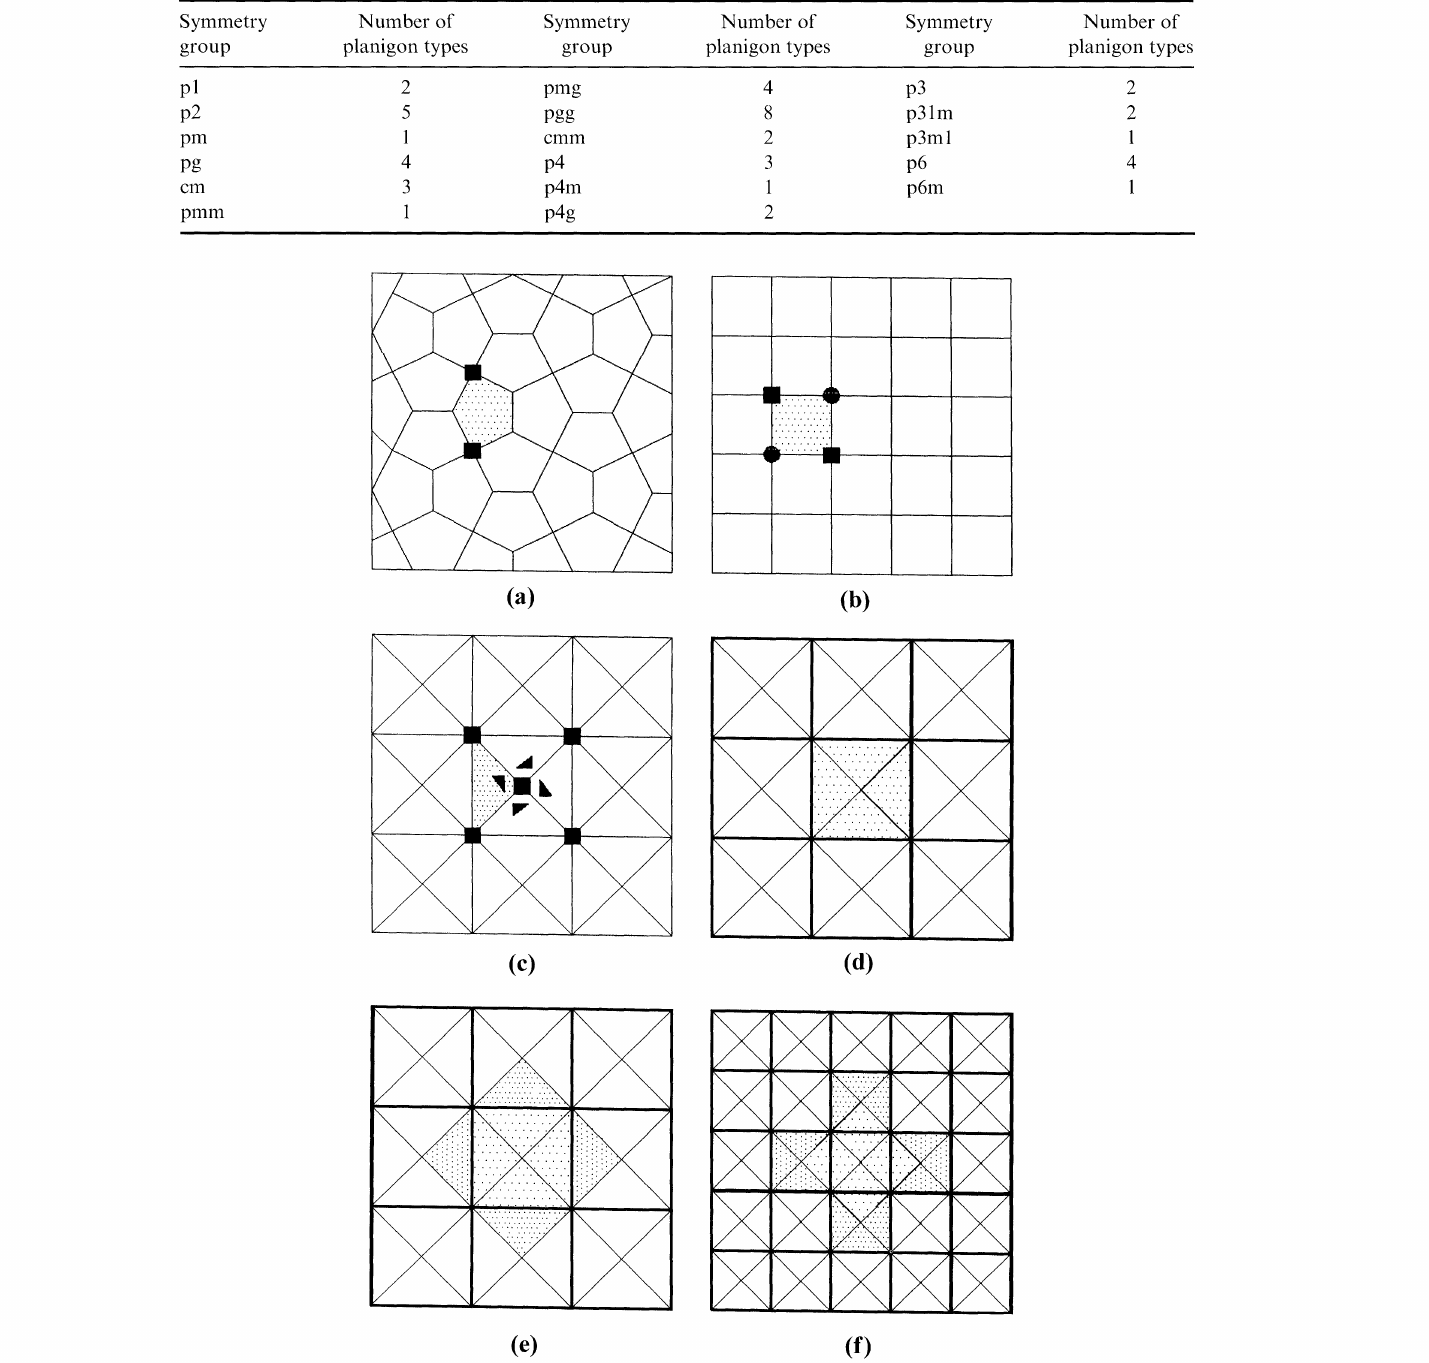
TABLE The number of planigon tessellations corresponding to each two-dimensional crystallographic group Symmetry